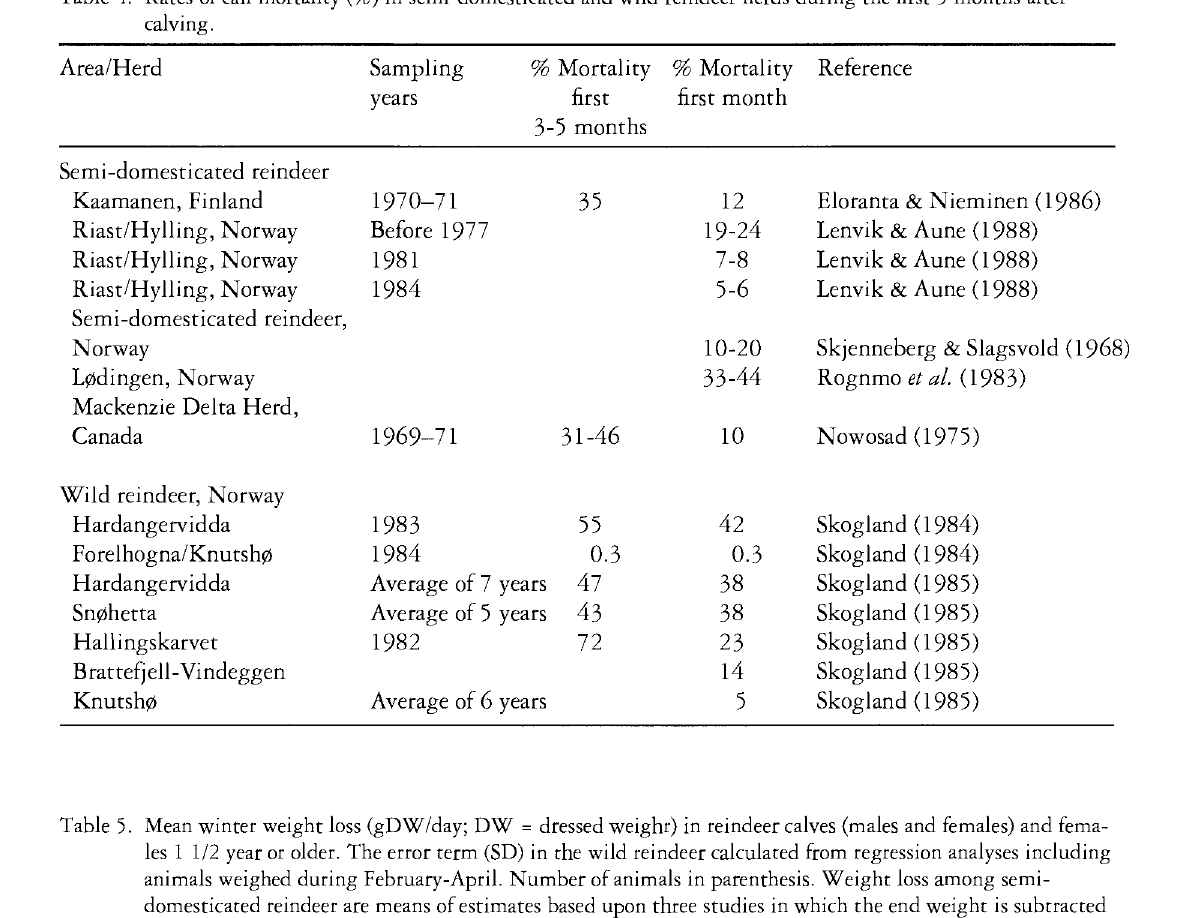
Table 5. Mean winter weight loss (gDW/day; DW = dressed weighr) in reindeer calves (males and females) and fema les 1 1/2 year or older. The error term (SD) in the wild reindeer calculated from regression analyses including animals weighed during February-April. Number of animals in parenthesis. Weight loss among semi- domesticated reindeer are means of estimates based upon three studies in which the end weight is subtracted from the start weight and the result divided with the number of